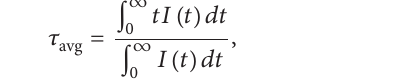
emission level of Eu 3+ in Mg 0